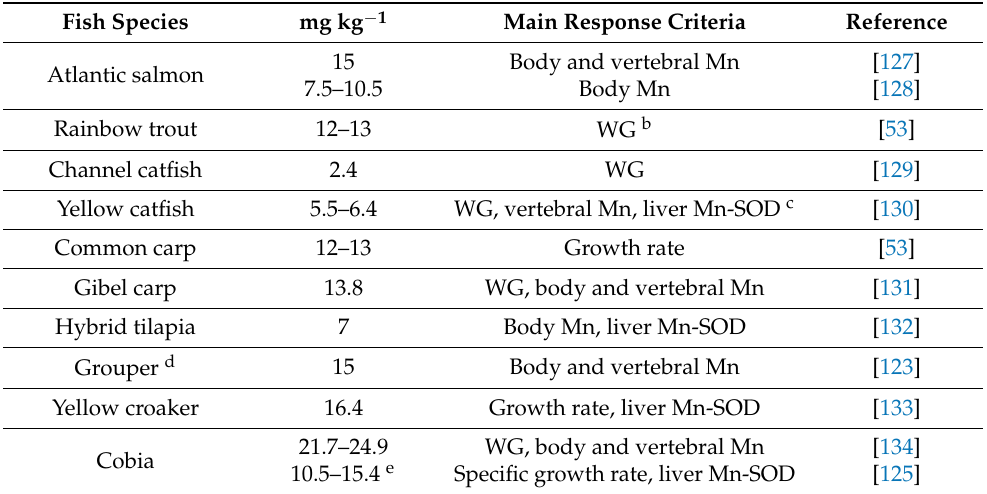
Table 2. Manganese requirements of certain fish a